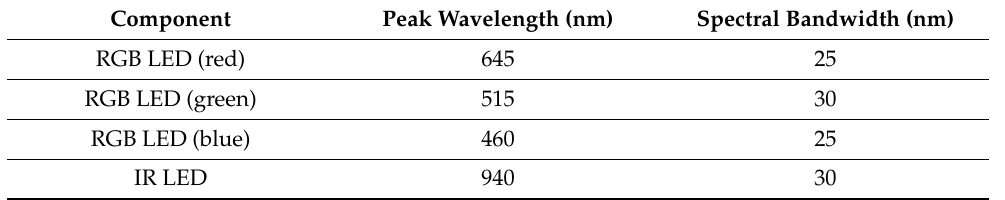
Figure 3. Circuit diagram of D-SPARC units and components. Table 1. Technical LED details of D-SPARC